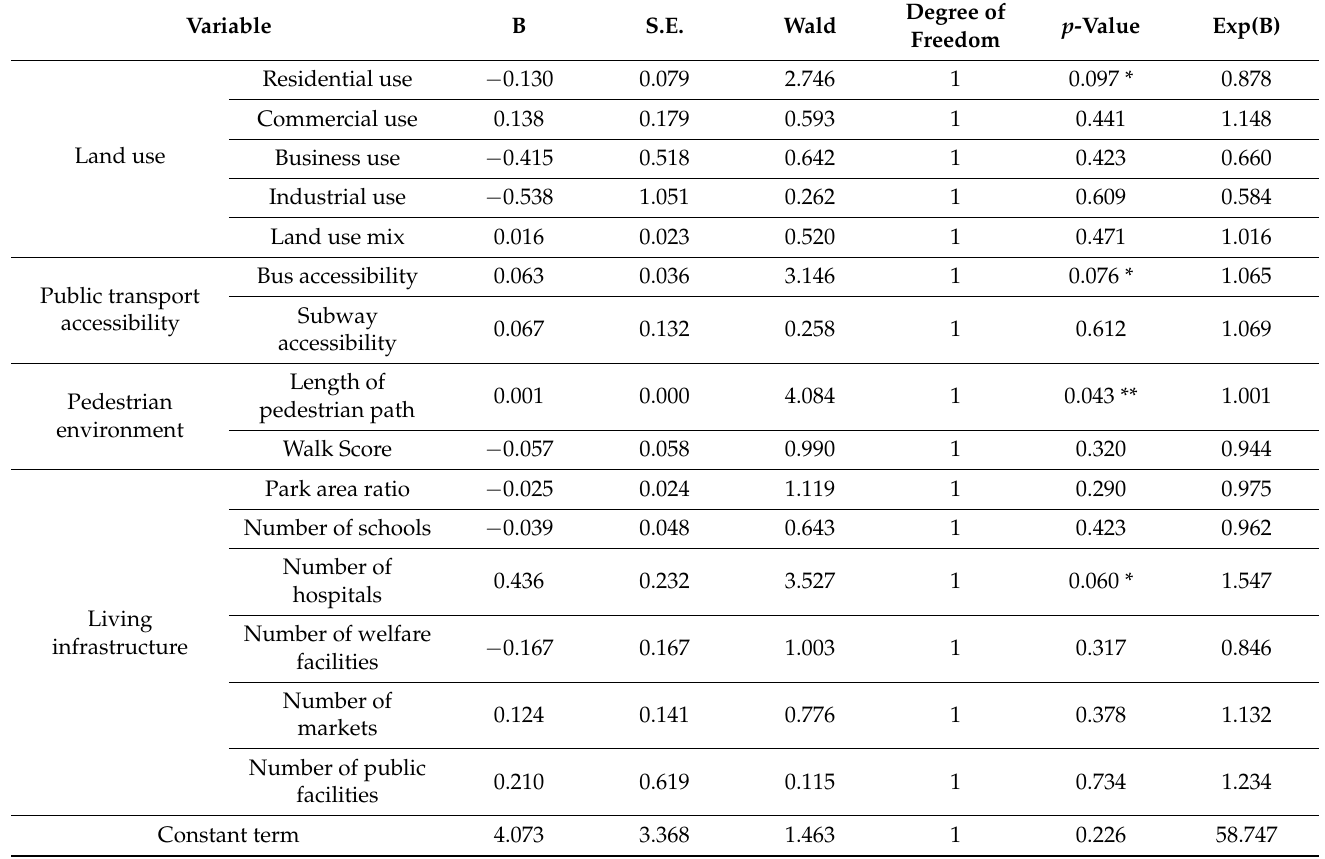
Table 5. Results of logistic regression analysis